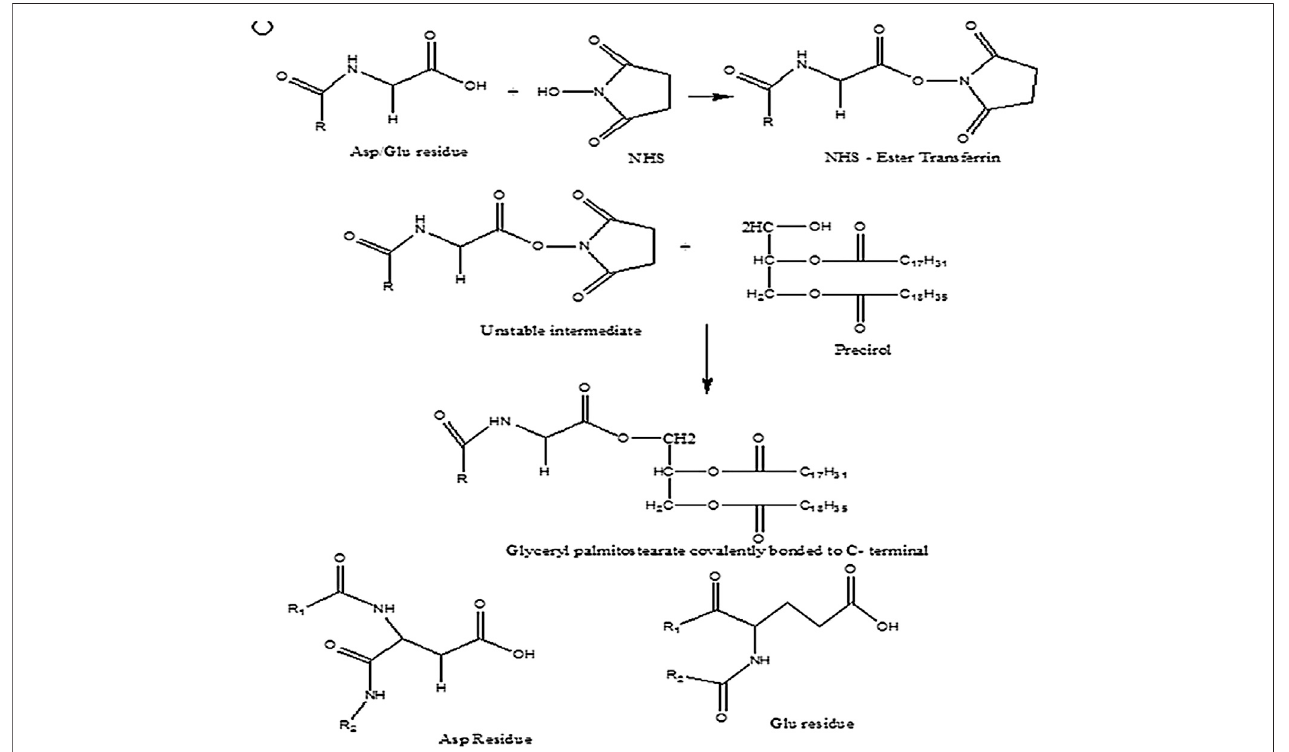
FIGURE 1 | Conjugation of transferrin to lipid by covalent